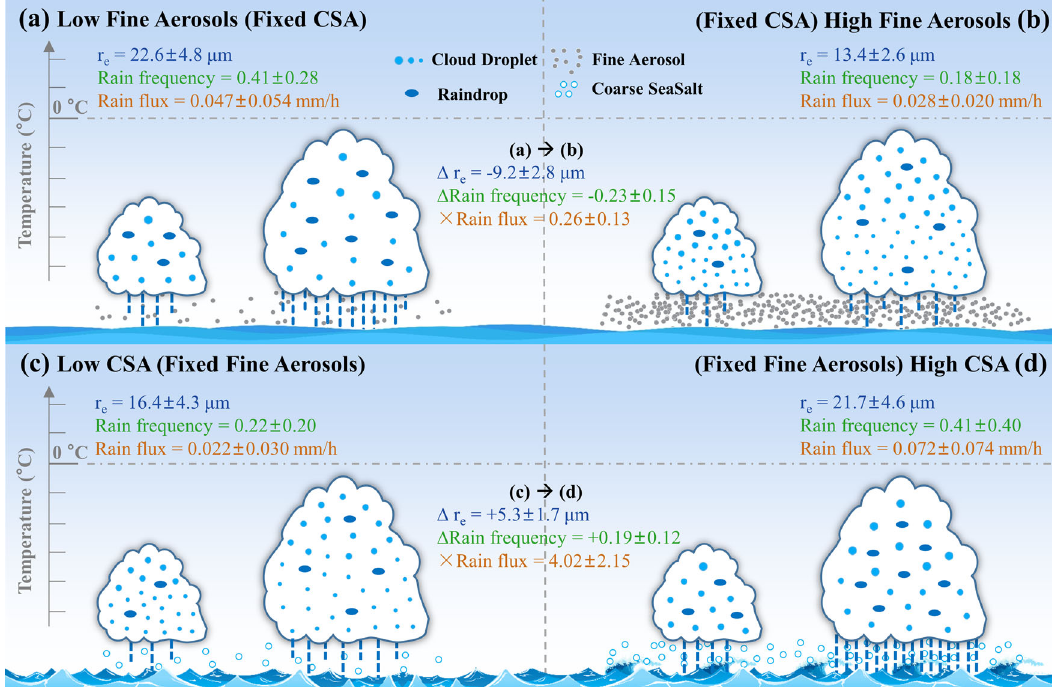
Fig. 7 Conceptual representation of the comparable but opposite effects of fi ne aerosol and coarse sea spray aerosols (CSA) on the rainfall of marine warm clouds. The averaged r e and rainfall of shallow (low LWP) and thick (high LWP) warm clouds are characterized at different fi ne aerosol and CSA conditions, including ( a , b ) low and high fi ne aerosol concentrations at fi xed both LWP and CSA concentrations, c , d low and high CSA concentrations at fi xed both of LWP and fi ne aerosol concentrations. The changes upon transition between states are marked by the arrows and the adjacent numbers. With the added fi ne aerosols from low to high concentration (from a to b ), the r e , rainfall frequency, and fl ux are synchronously reduced by added drop concentrations whatever the low and high CSA concentrations. In contrast, the added CSA from low to high concentration (from c to d ) activates the early formation of large cloud drops and suppresses the activation of fi ne aerosols, thus simultaneously increases r e , rainfall frequency and rainfall fl ux. Statistics of averaged r e and rainfall of panels a , b were obtained from Fig. 4 and Table S1, while panels c , d were from Fig. 5 and Table